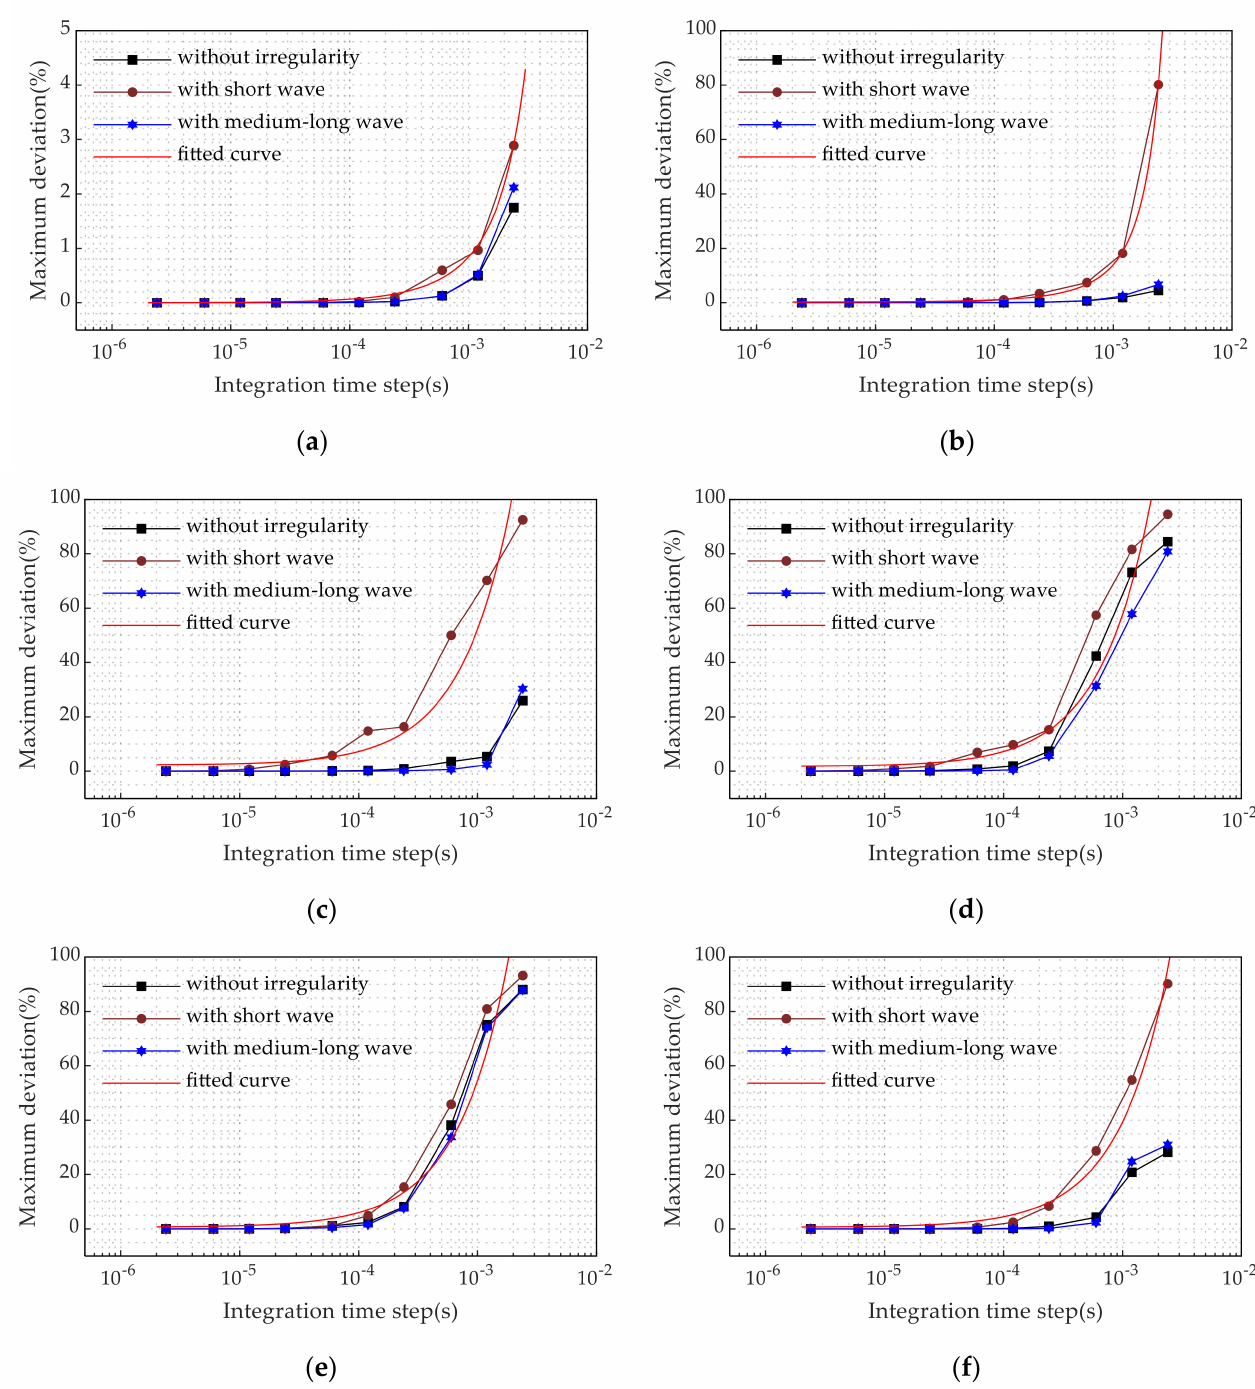
Figure 12. The effect of the integration time step on the maximum vertical acceleration of the: ( a ) car body; ( b ) bogie; ( c ) wheel-sets; ( d ) rail; ( e ) track slab; ( f ) bridge under different track irregularity